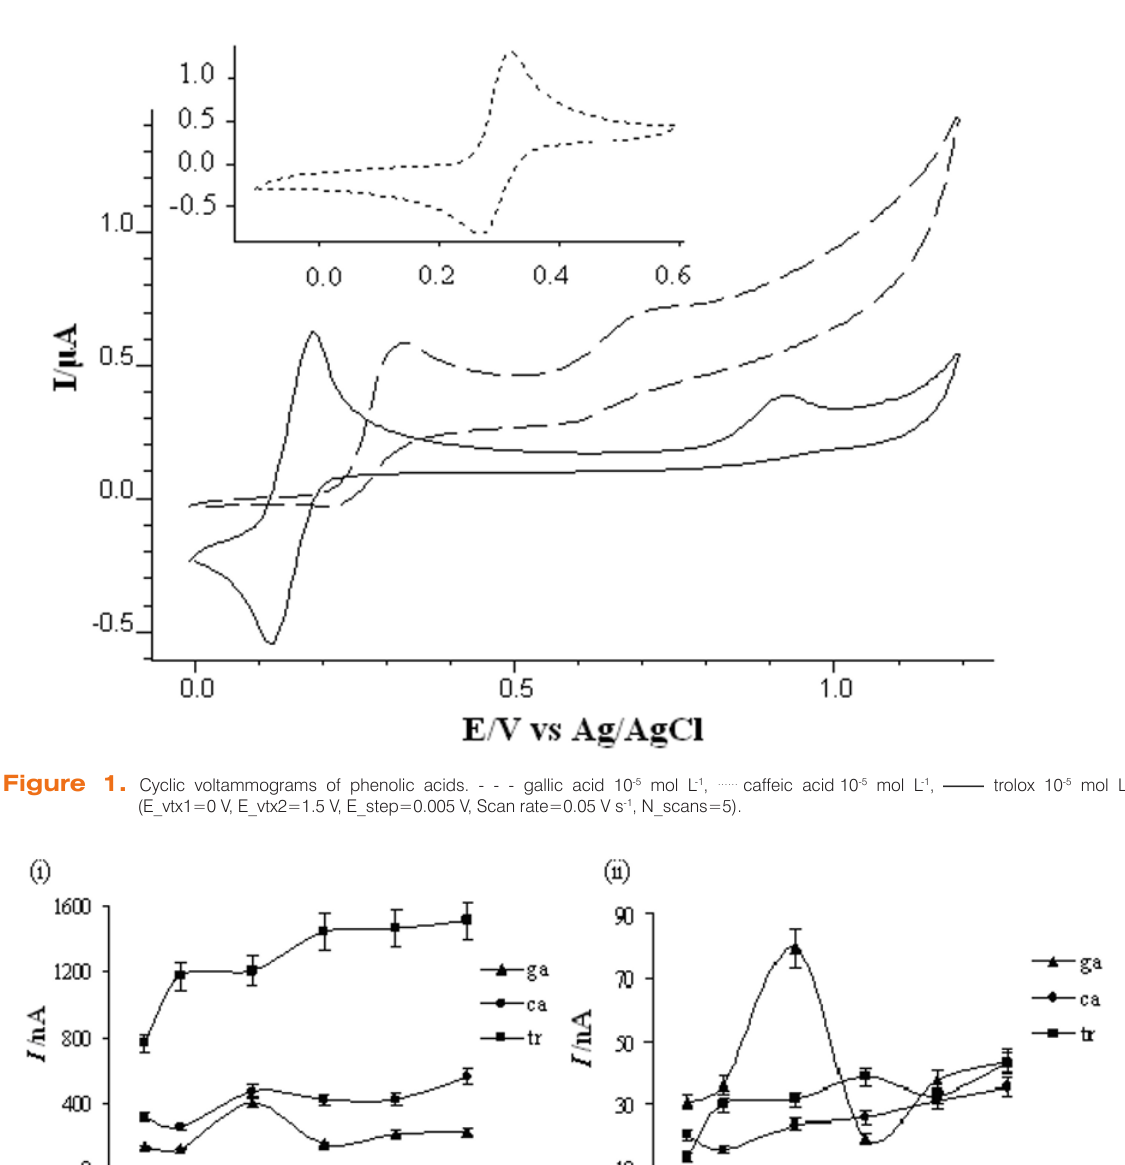
Figure 2. Dependence of the DPV response on the accumulation potential for both anodic peaks of phenolic acids (i) first peak at 0.2 V for gallic acid and caffeic acid and 0.075 V for trolox, (ii) second peak at 0.6 V for gallic acid and 0.8 V for caffeic acid and trolox ( c = c = c = 10 -5 mol L -1 , t .=60 gallic acid caffeic acid trolox accum